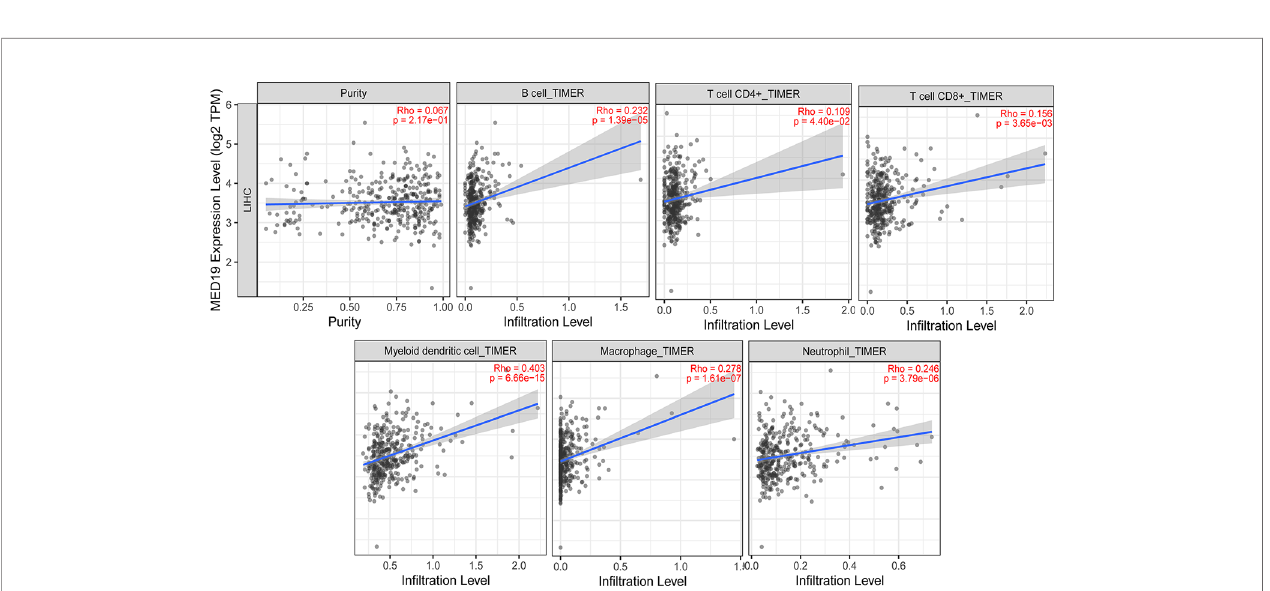
FIGURE 6 | Genes differentially expressed in correlation with MED19 in hepatocellular carcinoma. (A) A Pearson test was used to analyze correlations between MED19 and genes differentially expressed in HCC. In the volcano map, red indicates positively correlated genes and green indicates negatively correlated genes. (B, C) Heat maps showing genes positively and negatively correlated with MED19 in HCC (TOP 50).